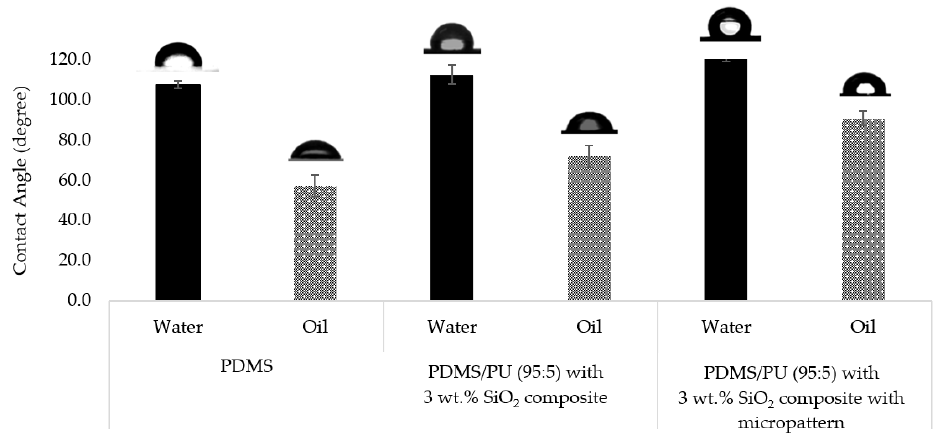
Figure 14. Water contact angle and oil contact angle on various material